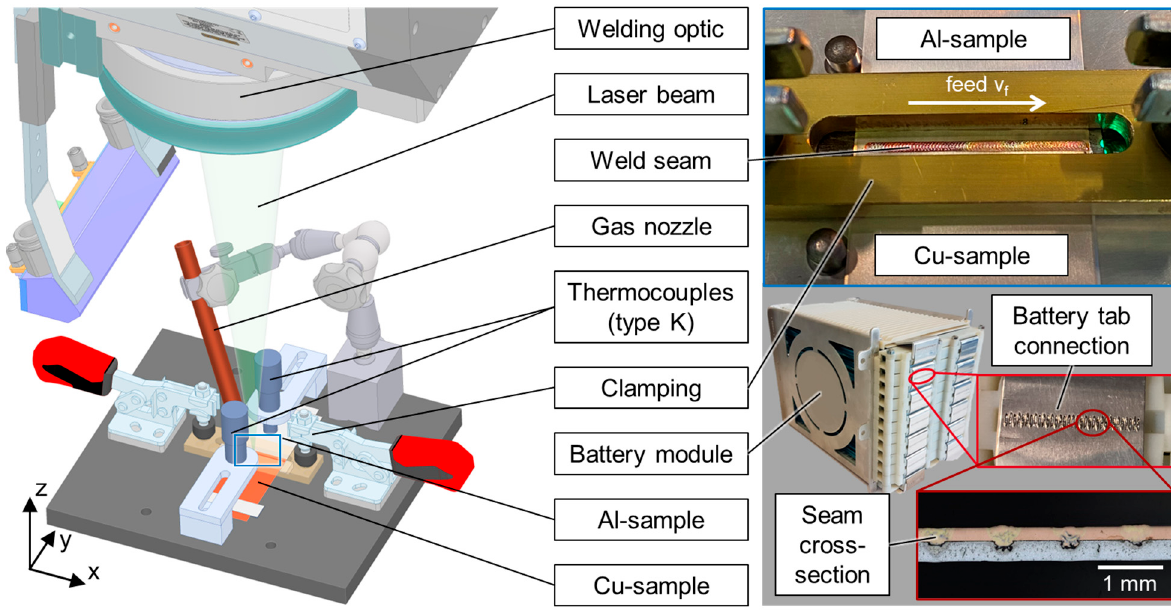
Figure 2. Schematic sketch (CAD-model) of the experimental setup for overlap welding from copper to aluminum, ( left ); detail insert of a welded sample in the real setup ( right, top ) and application in battery tab connections for electric vehicles ( right, bottom ).